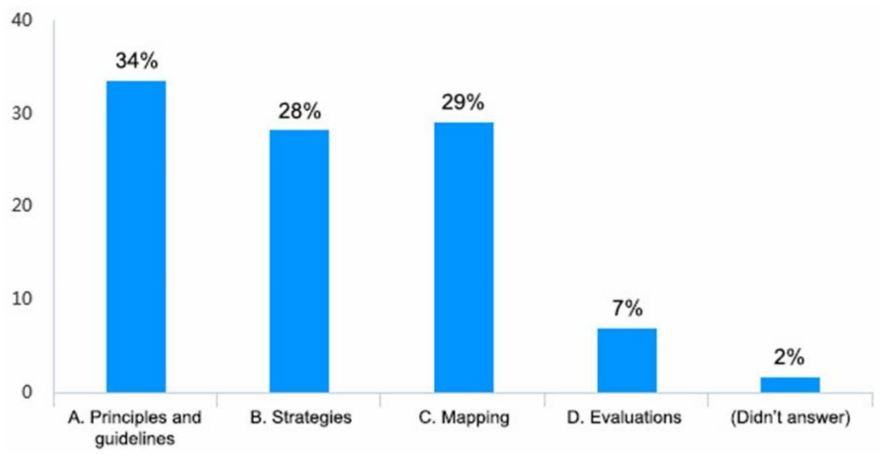
Figure 5. Question 4. The most commonly used microclimatic design method (respondents under- stand the four methods).